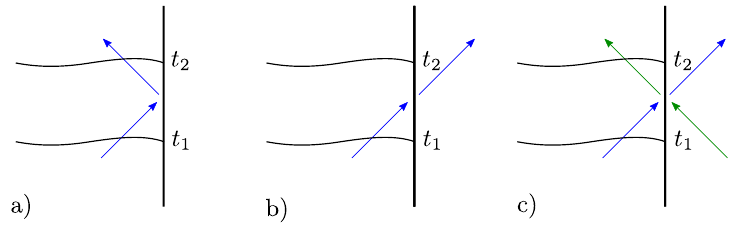
Figure 3 . We consider three types of boundary conditions: a) re(cid:13)ecting, b) absorbing, and c) open. For absorbing and open boundary conditions, the choice of the Cauchy slice for evaluating the von Neumann entropy is no longer immaterial, as degrees of freedom can enter and exit the